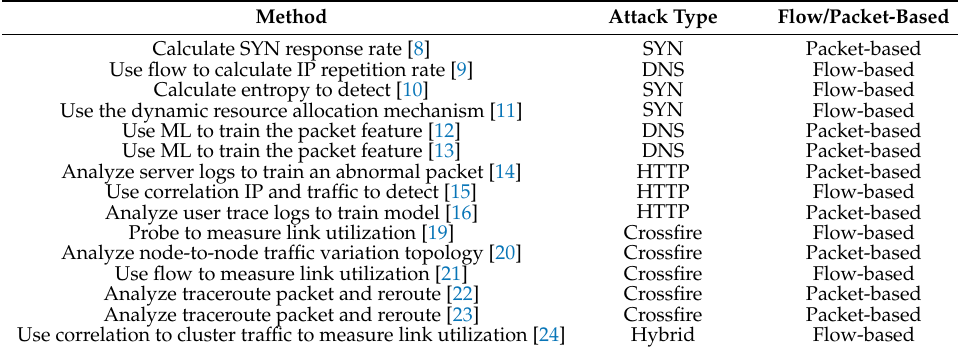
Table 1. DDoS attack detection comparison